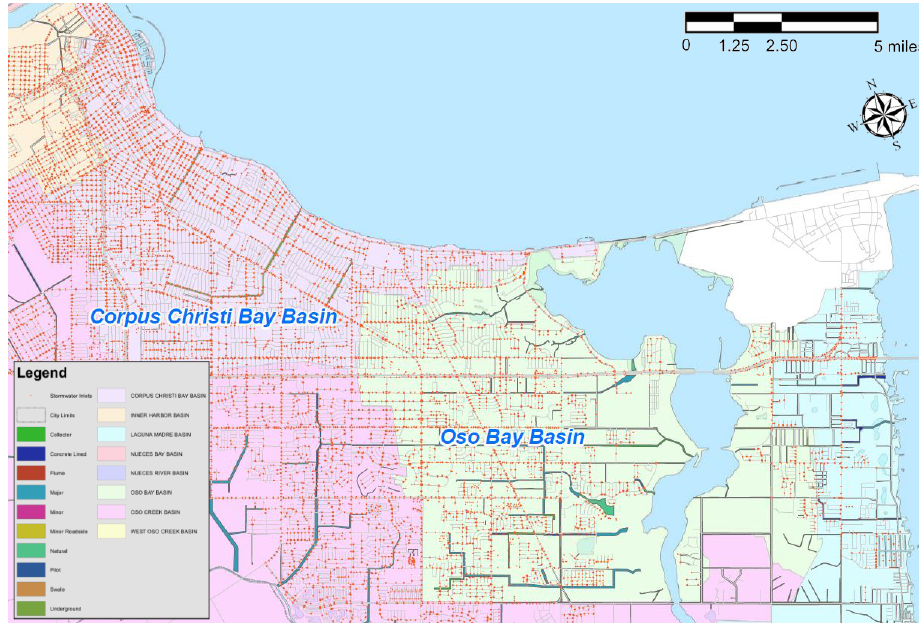
Figure 9. Parts of the city of Corpus Christi with storm sewer